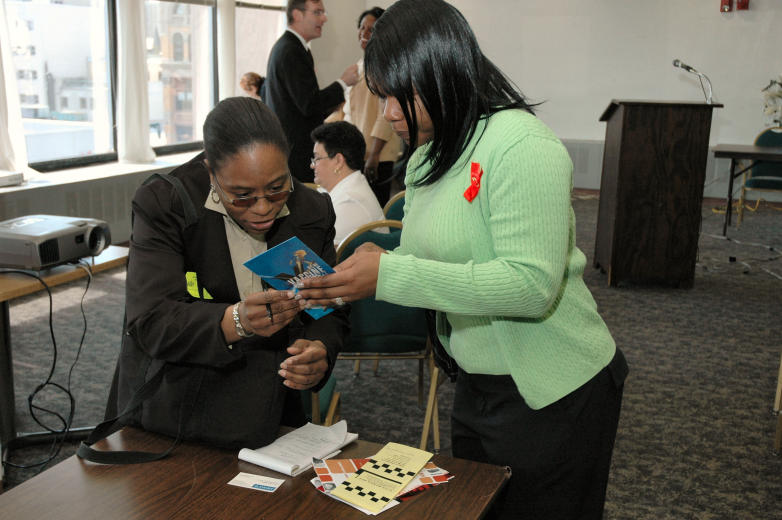
HIV Vaccine Awareness Day at the AIDS Community Health Initiative Enroute to a Vaccine Effort (Project ACHIEVE), 18 May 2005(Photo: Project ACHIEVE)